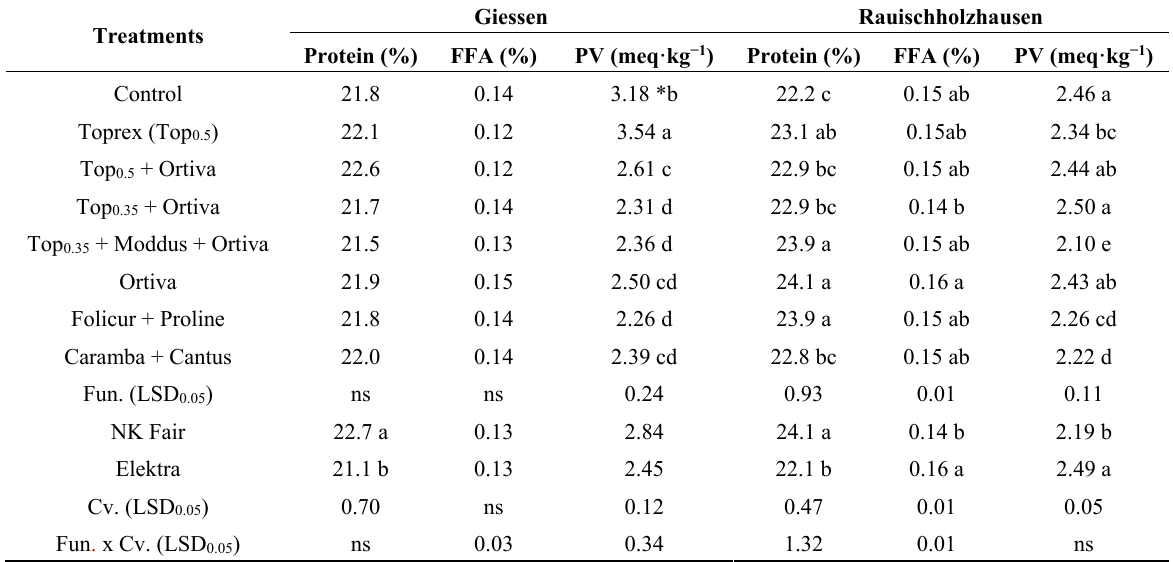
Fun. x Cv. (LSD 0.05 )